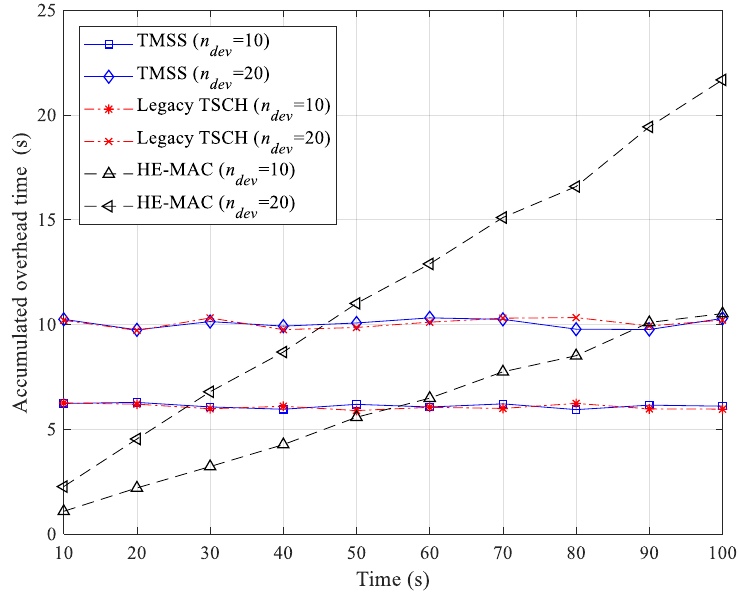
Figure 9. Accumulated overhead time.